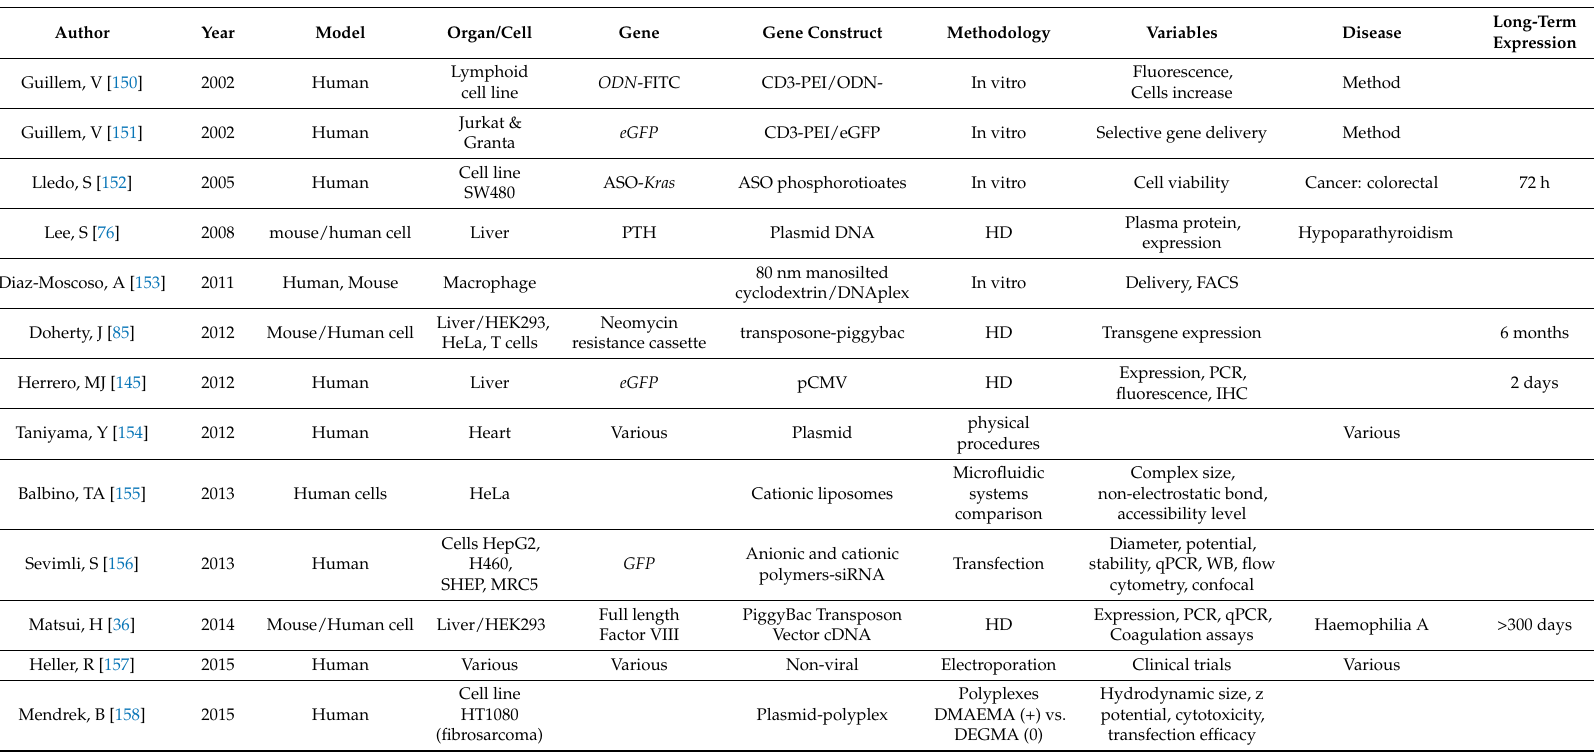
Table 5. Hydrodynamic gene transfer works performed in human models. The table shows the author of each work, the publication year, the human model studied, the target cell or organ assayed, gene and gene construction, injection methodology, variables evaluated, disease of interest and effect